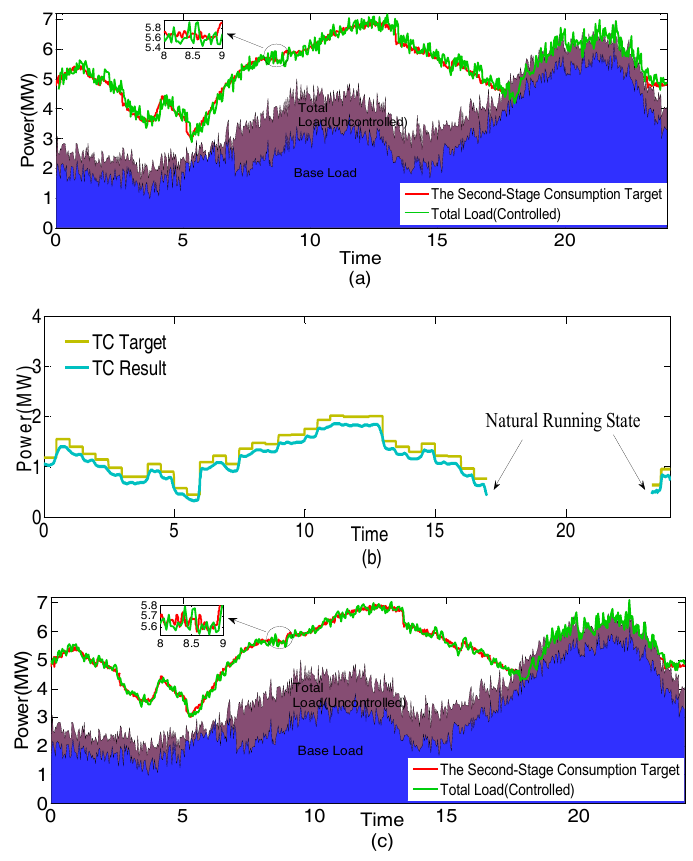
Figure 9. Consumption results: ( a ) the second-stage consumption result without delay compensation; ( b ) TC consumption result; and ( c ) the second-stage consumption result considering delay compensation.